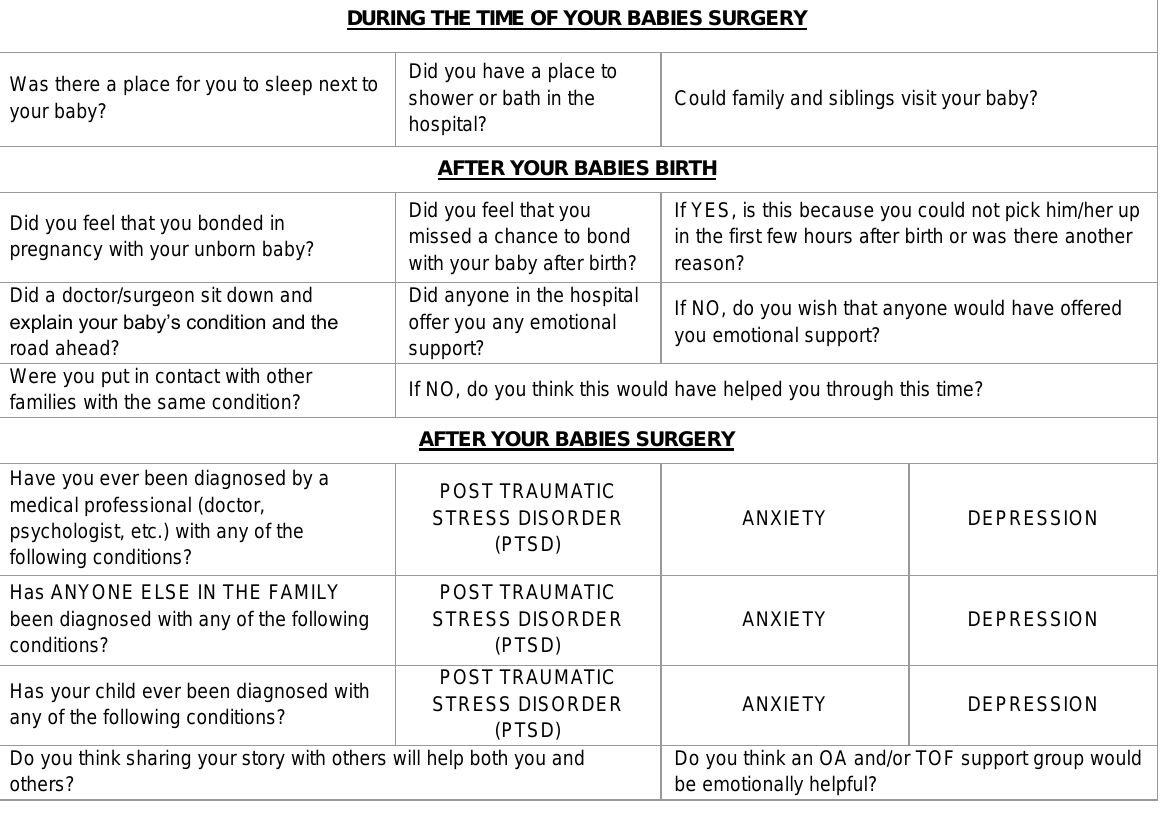
Table 2: Questions about the parents' need for emotional support DURING THE TIME OF YOUR BABIES